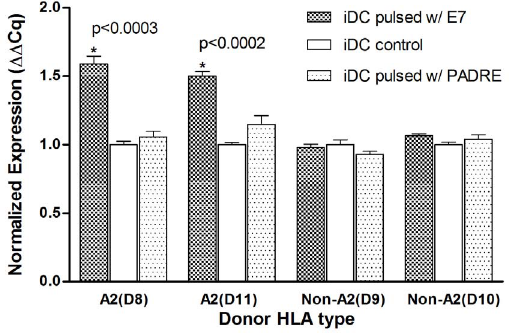
Figure 4. Quantification of NFKBIA gene expression after E7 peptide pulsing of iDCs derived from HLA-A2 disparate donors. iDCs derived from monocytes of two HLA-A2 and two non- HLA-A2 donors (D8–D11) were pulsed with the HLA-A2 binding E7 peptide and a non-natural peptide (PADRE) for 2 hrs. RNA was extracted and reverse transcribed to cDNA. b -actin was used as an internal gene control. Expression of NFKBIA in E7 and PADRE-pulsed iDCs from four different donors were compared to that of native